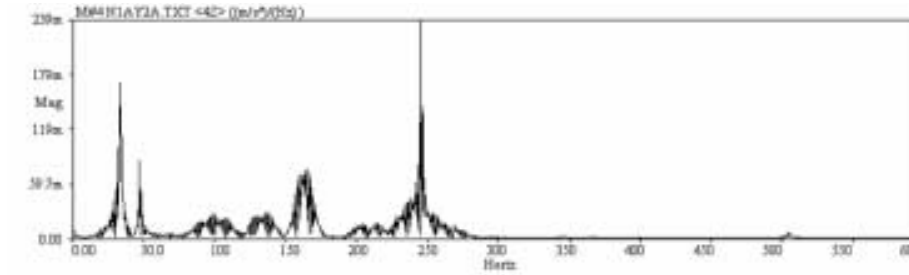
Fig. 23. Displacement vibration under y-excitation of motion stage.